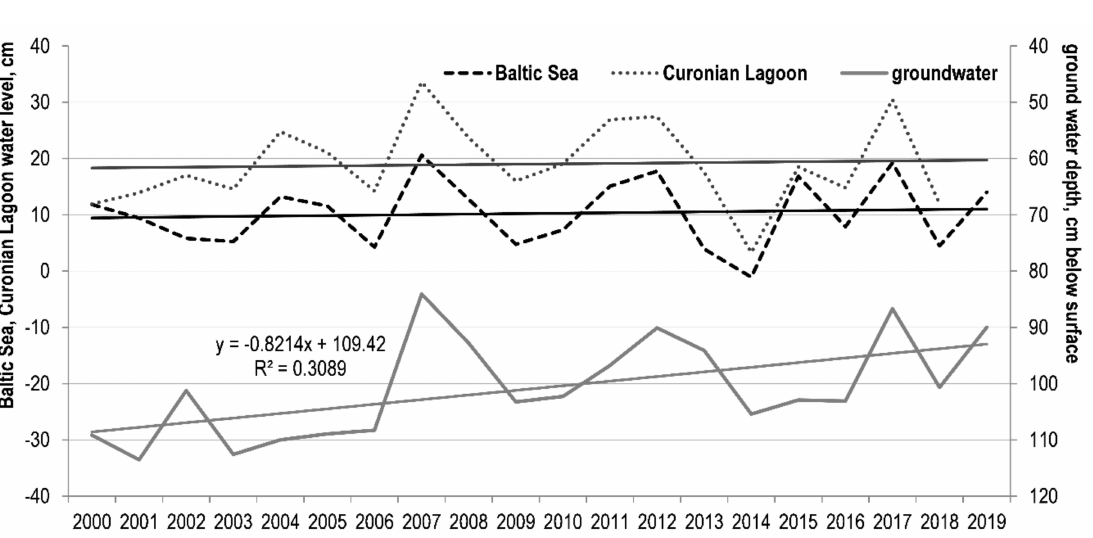
Figure 3. Variation and trends of average annual water level of the Baltic sea and the Curonian lagoon as well as the groundwater depth.